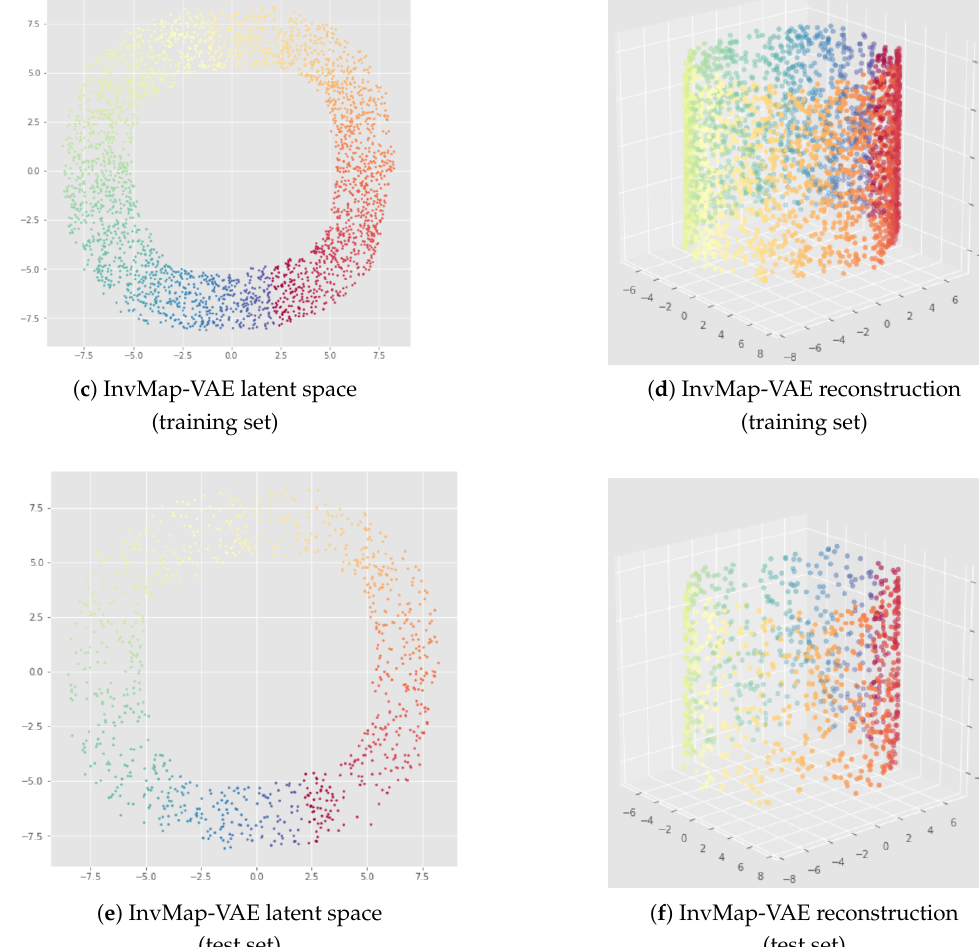
Figure 15. Isomap-based InvMap-VAE applied to the open cylinder dataset, weight IM = 1 and trained for 500 epochs. Betti numbers β 0 = 1 and β 1 = 1 are preserved between the original dataset ( a ), the latent representation (( c ) for training and ( e ) for test), and the reconstruction (( d ) for training and ( f ) for test). Moreover, on the contrary to the Isomap embedding ( b ), the latent representations are not too thin or “compressed”, which is better for interpolations.